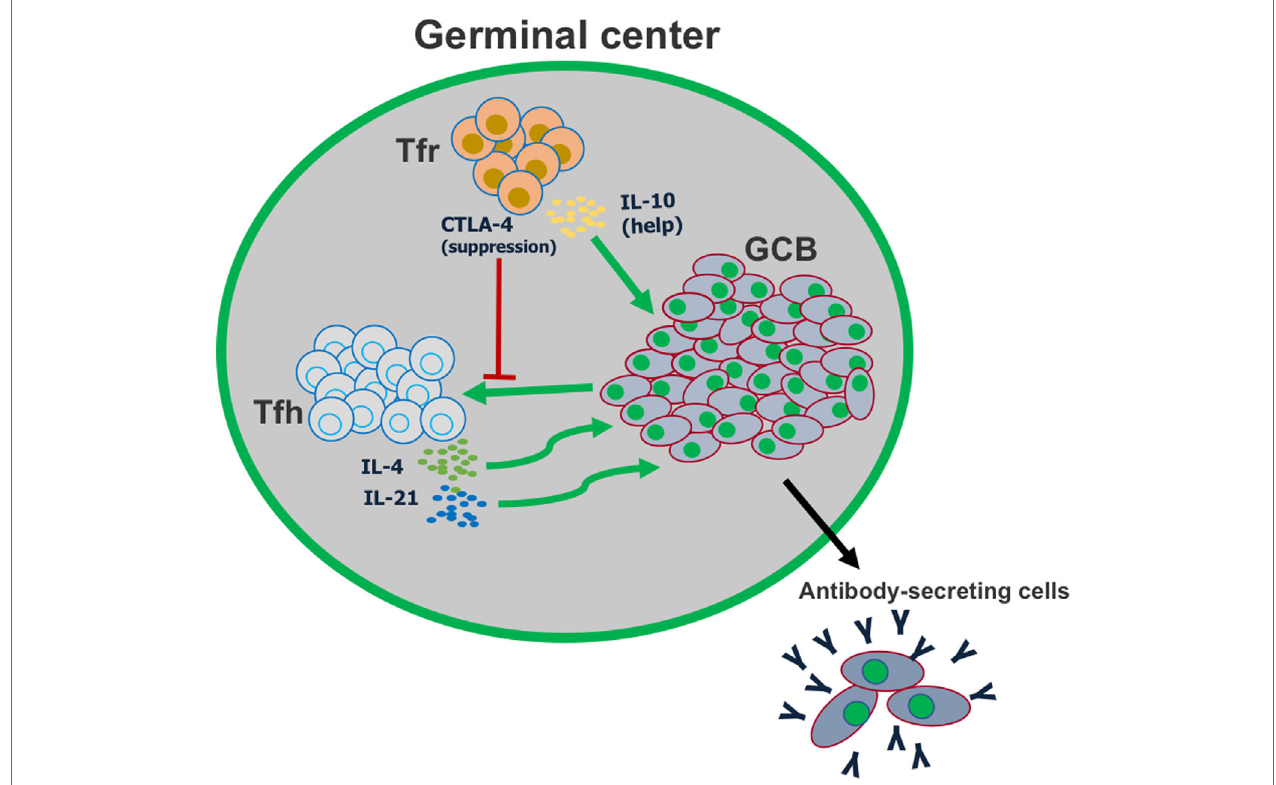
FiGURe 3 | T follicular regulatory (Tfr) cells play a dual role in the germinal center reaction. Tfr cells can suppress the activation of follicular helper T (Tfh) cells, in part by CTLA-4-mediated inhibition of co-stimulation. However, Tfr cells also play a major role in helping promote germinal center B cell proliferation, by producing